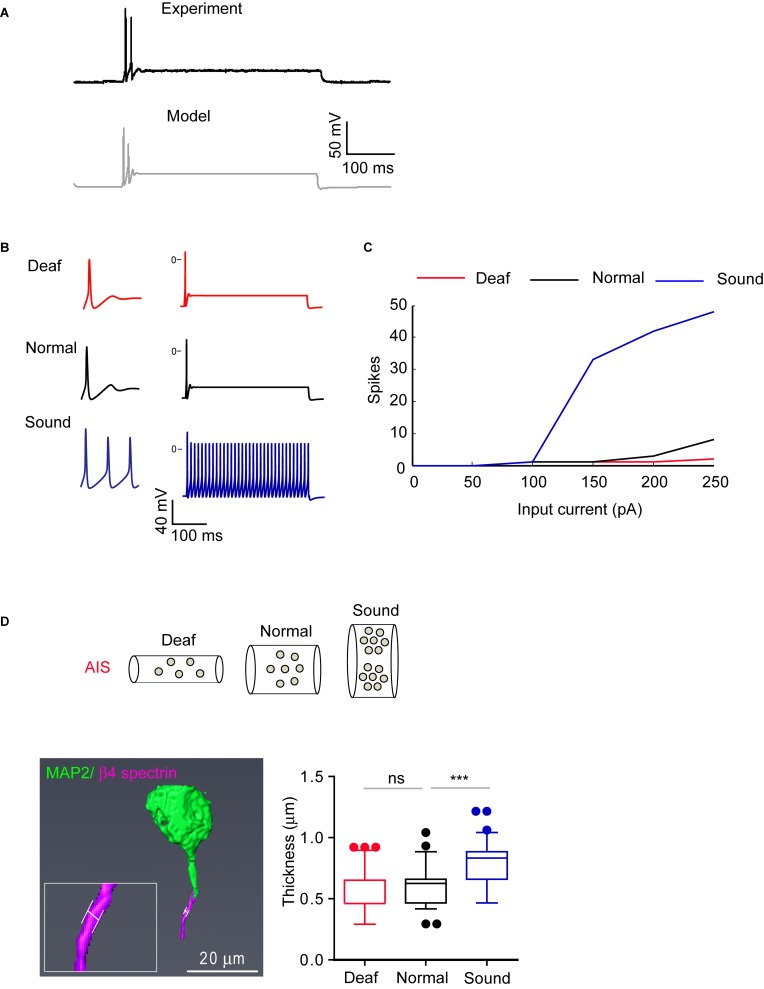
AIS structural changes in sound stimulated group are associated with alteration in firing properties. (A) Representative AP evoked by current injection (200 pA) from MNTB neurons in normal hearing mouse (black, experiment) and modeling of MNTB neuron from a computer simulation (gray, model). (B) Representative traces of the model when stimulated by 200 pA of constant current with parameters that correspond to the Deaf, Normal, and Sound. (C) Summary of AP number evoked by current injection (50 pA–250 pA) from Deaf (red), Normal (black), and Sound (blue) using computer simulation (top). (D) Expected AIS structure with ion channel expression from Deaf, Normal, and Sound (bottom). Note, axon diameter is changed in sound modified groups. Bottom, an example of 3D reconstruction of MNTB neuron at P20 mice immunostained with β4 spectrin and MAP2. The white line indicates the thickness of AIS (left). Summary of AIS diameter from Deaf (red), Normal (black), and Sound (blue). ∗∗∗p < 0.0001, one-way ANOVA with Turkey’s multiple comparison test.